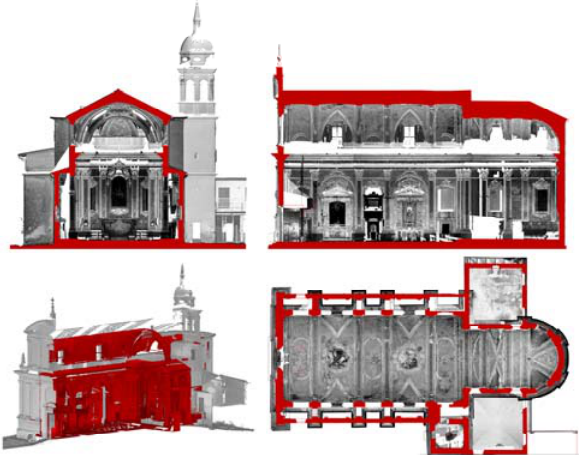
Figure 2: Church of Surcinesco: view of the pointclound (interior in red, exterior in grey) and the outcomes of the survey. The photographic content is given by an orthophoto extracted from the point